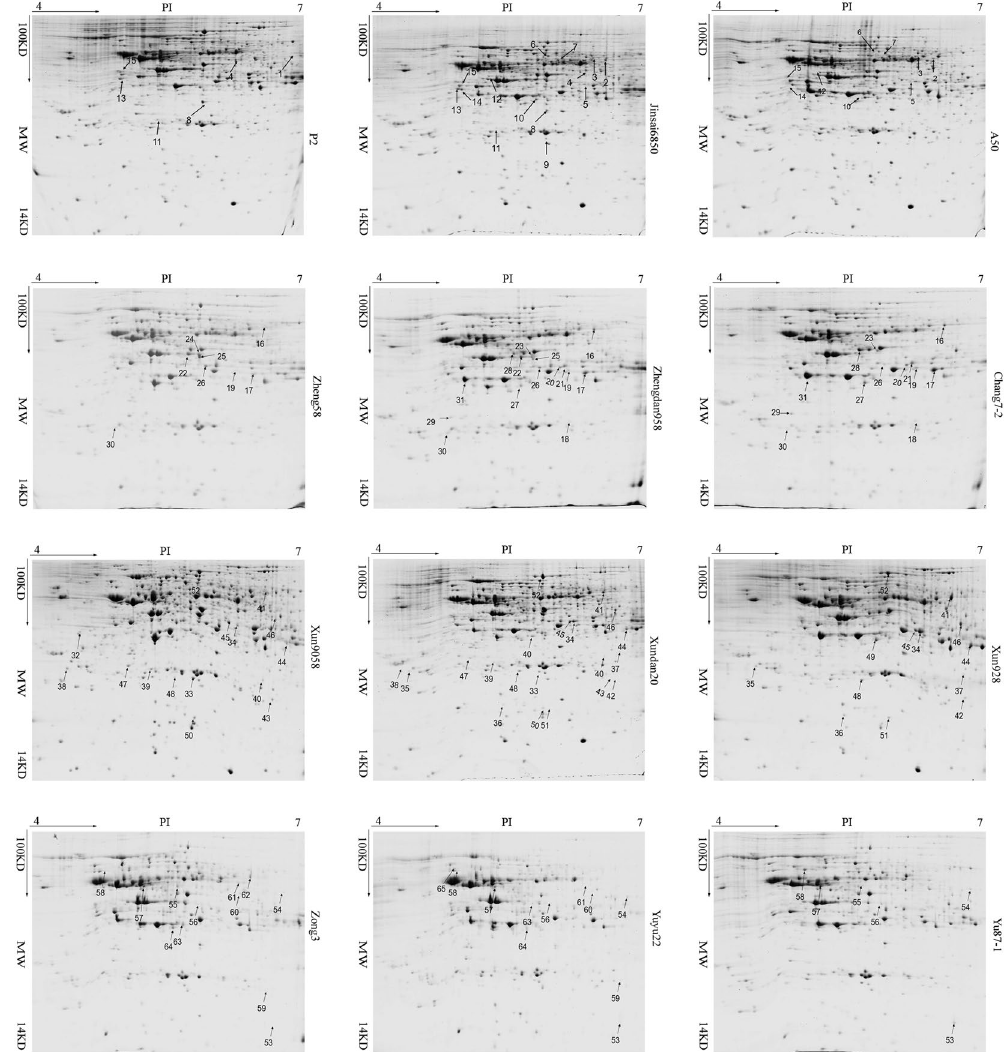
Figure 3. Two-dimensional maps of differentially accumulated proteins in the eighth internode of the hybrids and parental inbred lines. Proteins that accumulated differentially in hybrids and parental inbred lines are